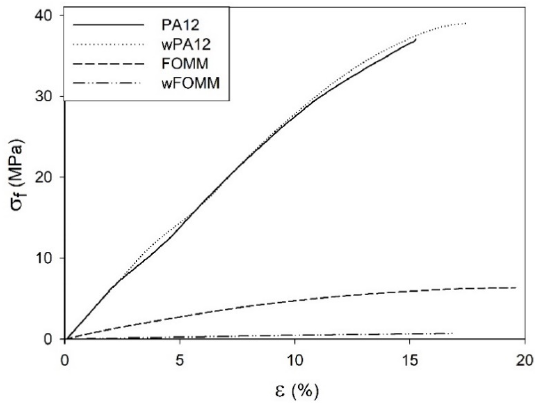
Figure 10. Stress–strain representative 3PB curves of printed specimens.